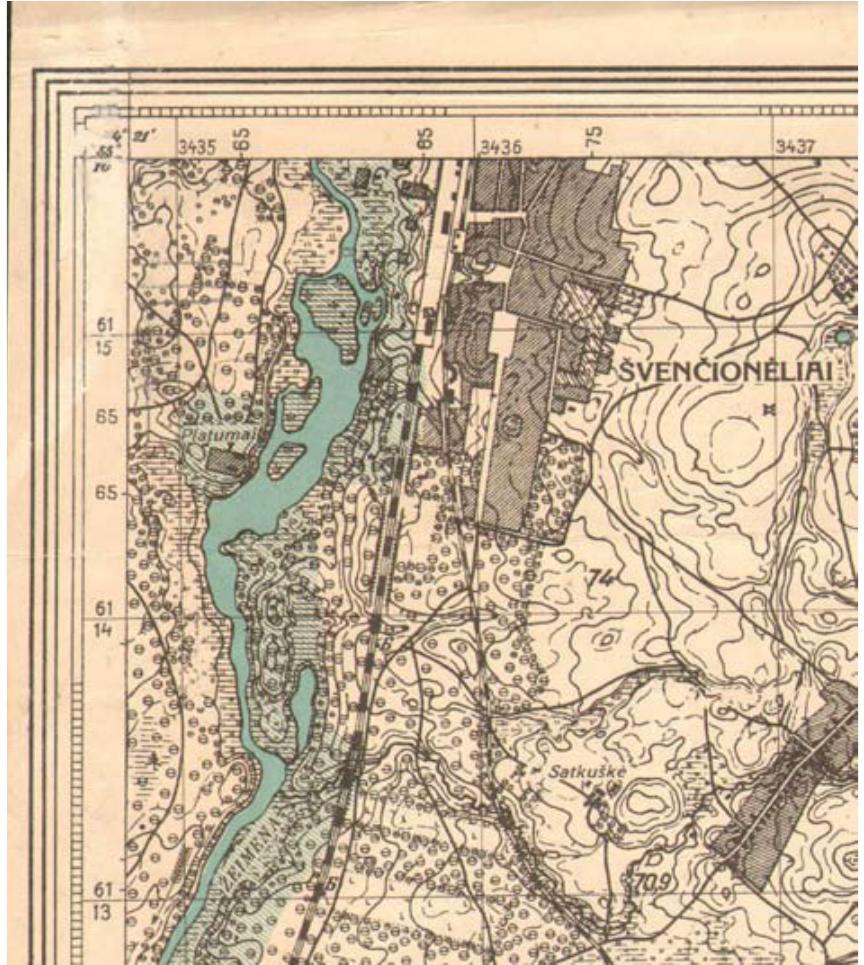
Fig. 3. Fragment of topographic map XI-20-E, scale 1:25